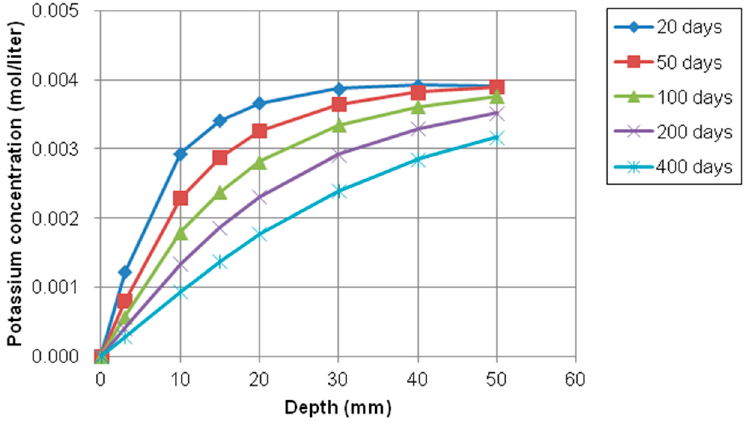
Figure 13. Profile of calcium concentration at different depth over time.